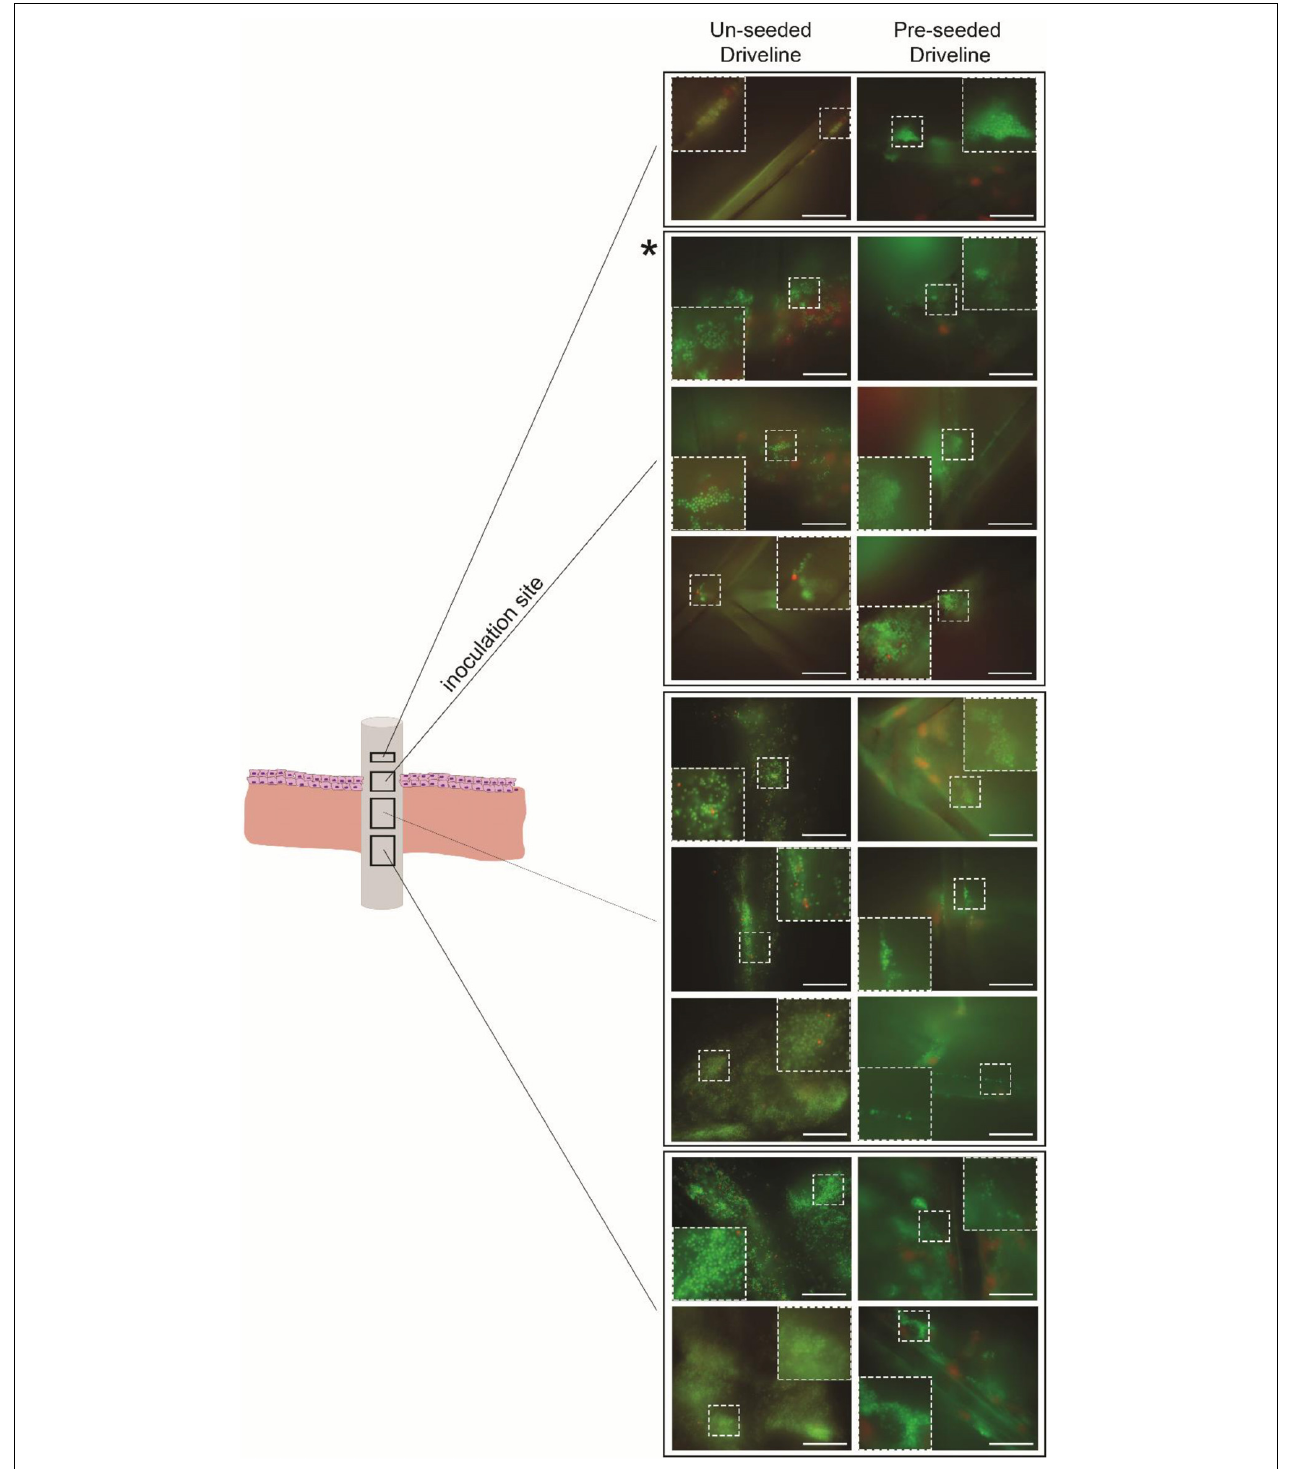
FIGURE 6 | Fluorescence microscopy of infected HSE-explanted drivelines. S. aureus cells were stained with bacterial LIVE/DEAD staining (live = green, dead = red). Live S. aureus cells (seen as green cocci) were present in the voids and on the fiber struts of the un-seeded and pre-seeded drivelines at the inoculation site (second quadrant from top, denoted by asterisk) and deeper down the driveline surface (left and right panels, respectively; Scale bars: 30 µ m). Inserts show a digitally zoomed section (25%) of the region marked by the white dotted line.